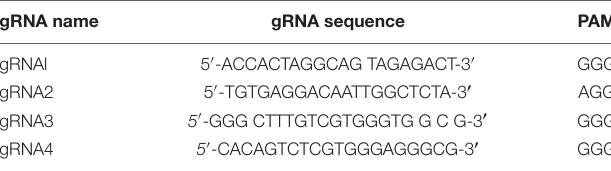
TABLE 1 | Sequence information of gRNA.